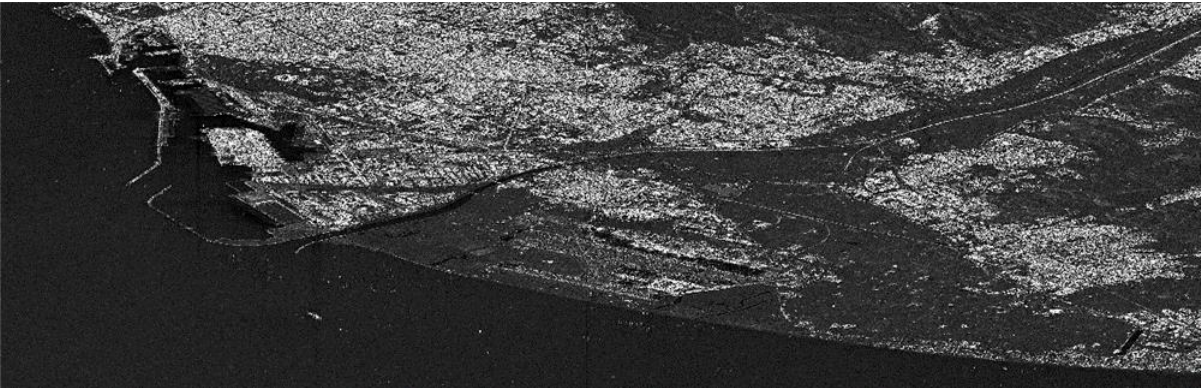
Figure 4. Omega factor over Barcelona (dark to bright indicates 0 to 1)